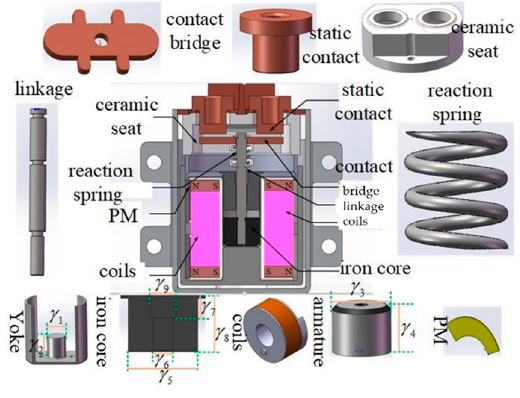
Figure 4. Electromagnetic device with double magnet.